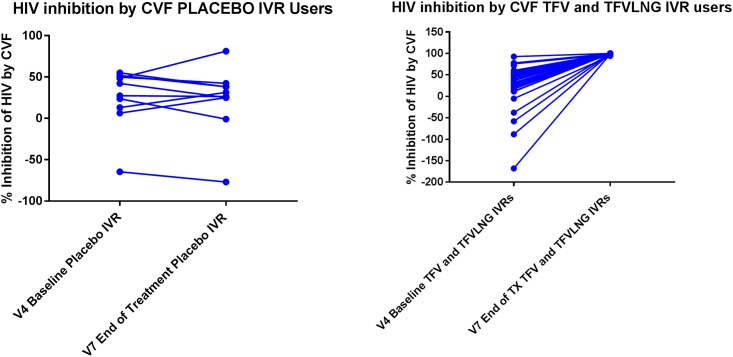
(A) HIV inhibition by cervico-vaginal fluids in vitro among placebo IVR users at baseline [visit 4] versus end of treatment [visit 7]. (B) HIV inhibition by cervico-vaginal fluids in vitro among TFV and TFV/LNG IVR users at baseline [visit 4] versus end of treatment [visit 7].